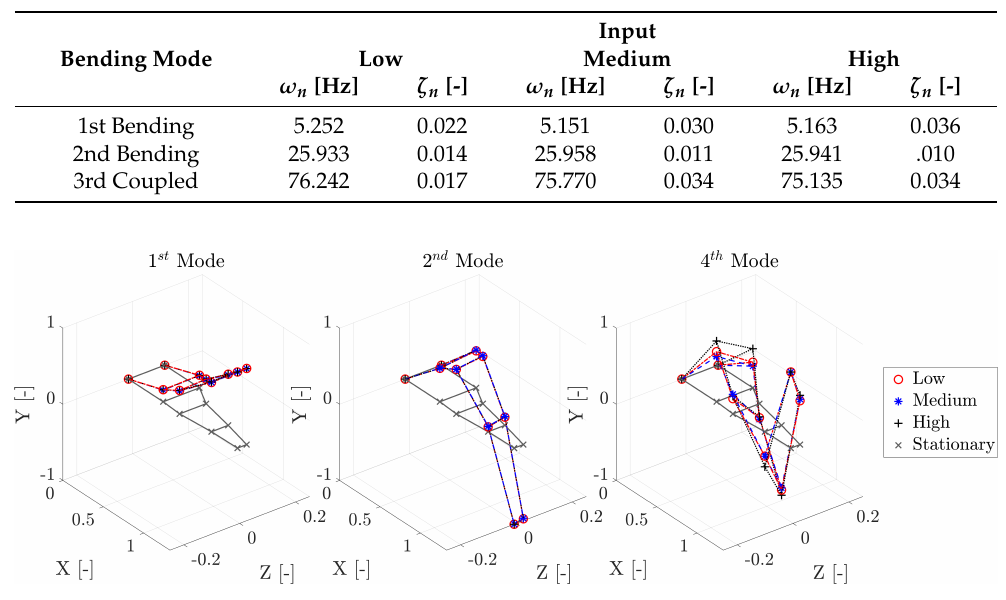
Figure 18. Spar and tube: Mode shapes of the first three vertically dominant modes.